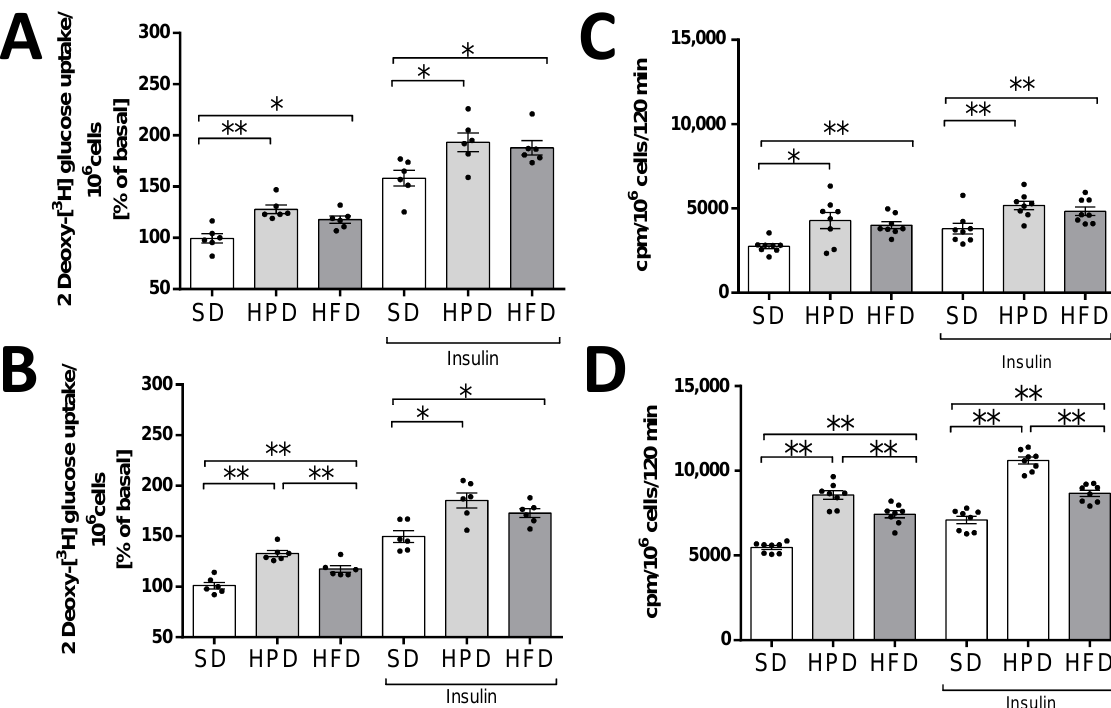
Figure 6. Effects of standard (SD), high-protein (HPD), and high-fat (HFD) diets on glucose uptake and lipogenesis in isolated adipocytes after 60 ( A , C ) and 120 days ( B , D ). Results are means ± SEM for n = 8 (lipogenesis experiments) and n = 6 (glucose uptake); significant differences between means for control and experimental groups are marked for p < 0.05 (*) and p < 0.01 (**).